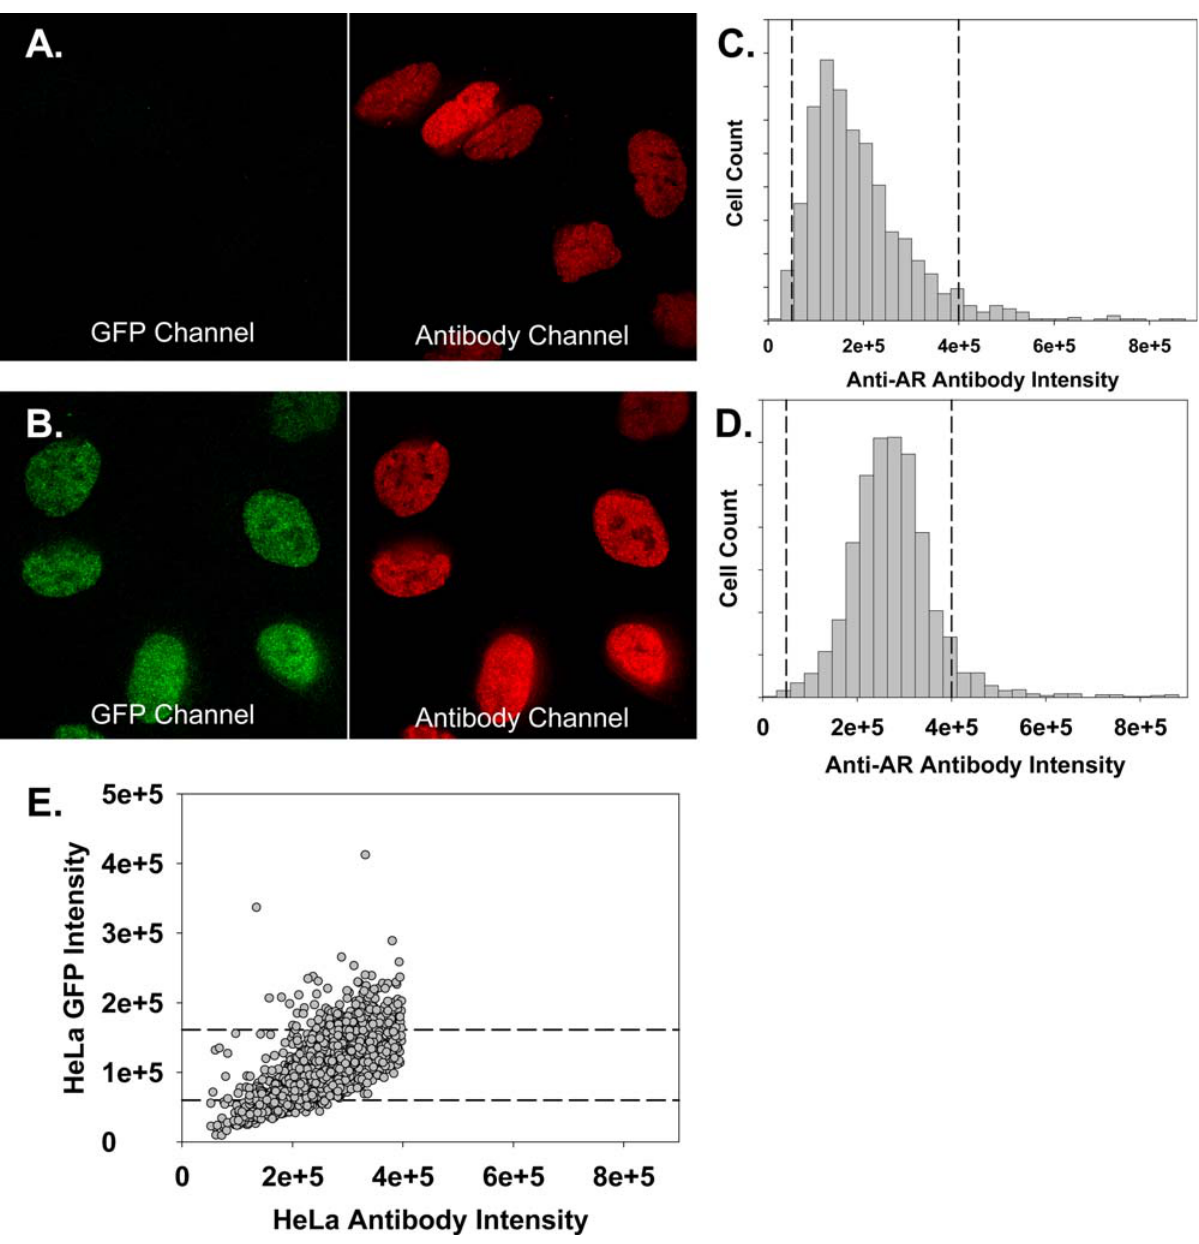
Figure 2. HTM analysis allows selection of cells expressing physiologically relevant levels of GFP-AR. A and B. Representative images of LNCaP cells ( A ) and HeLa cells stably transfected with GFP-AR ( B ) were immunolabeled and imaged to determine the GFP-AR signal that corresponds to endogenous LNCaP AR expression levels. Exposure levels for the GFP (left) and anti-AR labeling (right) is identical for both cell types. C . Image analysis was performed on the LNCaP antibody images to quantify the total anti-AR labeling per cell, derived from the standard 10 6 10 field of cells, containing . 500 cells. The dashed lines indicate the 10% and 90% percentile of the population. D . Similar image analysis was performed on the HeLa GFP-AR antibody images to quantify the total anti-AR labeling per cell. The dashed lines indicate the 10%–90% expression range found in the LNCaP cell line. These cut-offs were empirically determined to remove the outliers, either barely-detectable GFP, or grossly over-expressing cells. As can be seen in the histogram from the , 500 cell quantitation, removing the very heterogenous top 10%, or the more homogeneous bottom 10%, only eliminates the extremes, which can have an untoward influence on the bulk of the population. E . HeLa GFP-AR cells with AR expression within this range were selected and total GFP intensity per cell was determined and plotted. GFP expression corresponding to the 10% and 90% percentile in this population were determined (dashed lines) and used as lower and upper limits of GFP-AR expression in all subsequent experiments. This analysis enables the selection of HeLa GFP-AR cells with AR expression levels similar to that endogenously expressed in LNCaP cell line. fluorescent protein that is targeted to the peroxisomes, which minimal dose found to be sufficient to generate a response in all key measurements. Cells were imaged using an automated improves detection due to concentrating dsRED2skl in the small cytoplasmic organelles. When examining potential anti-androgen- microscope with a 40 6 /0.90 NA objective. For each field, three ic activity, test compounds were titred against 10 nM R1881, a images were captured: DAPI (nuclei, blue), GFP (AR, green), and